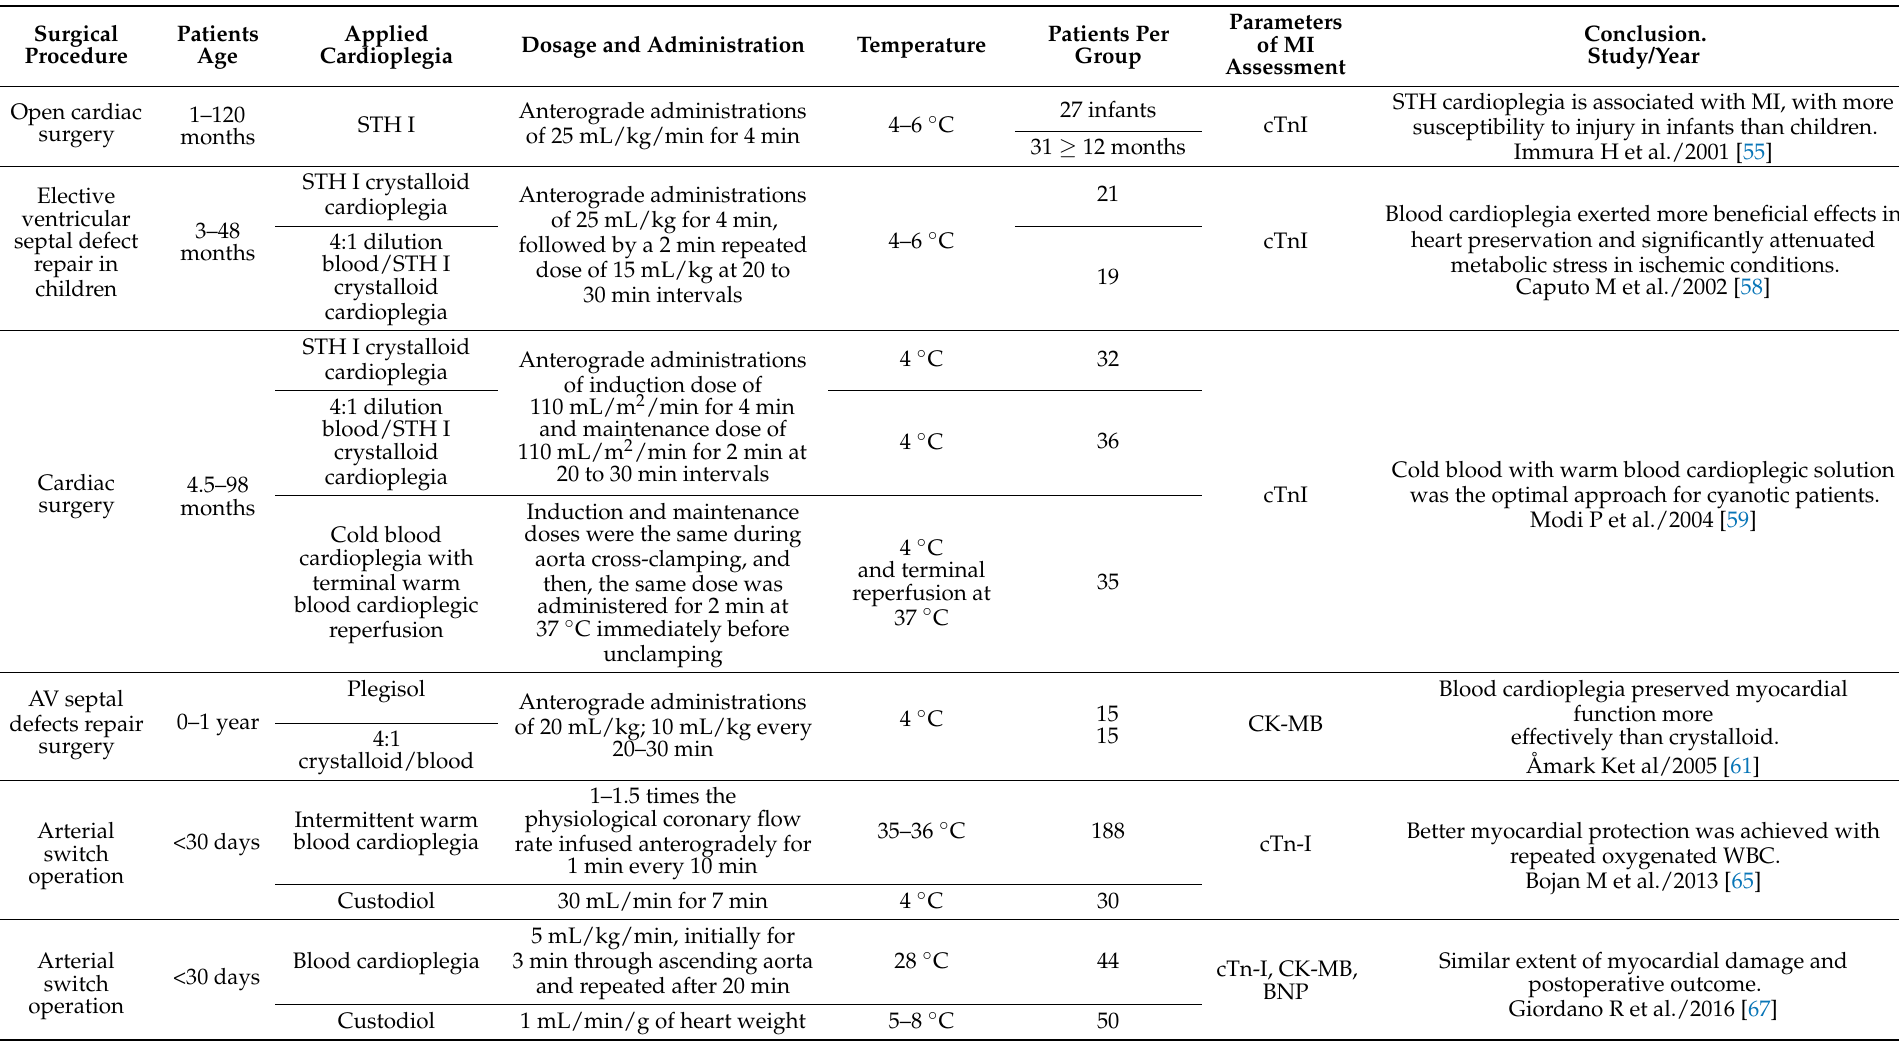
Table 3. Clinical studies in pediatric surgery in which markers of myocardial injury were